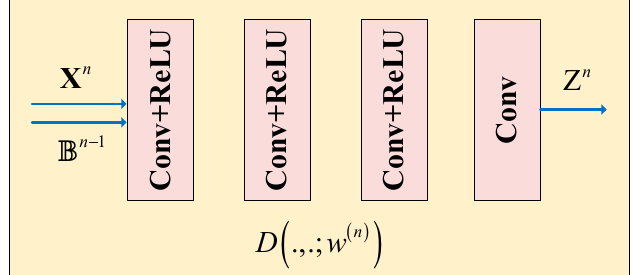
Figure 2. Structure of the denoising layer.